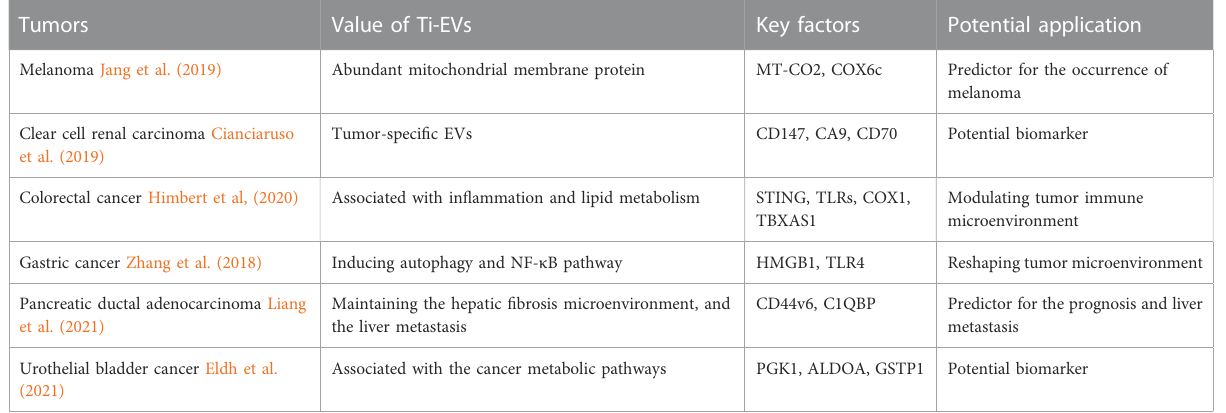
TABLE 2 The role of Ti-EVs in diverse tumor